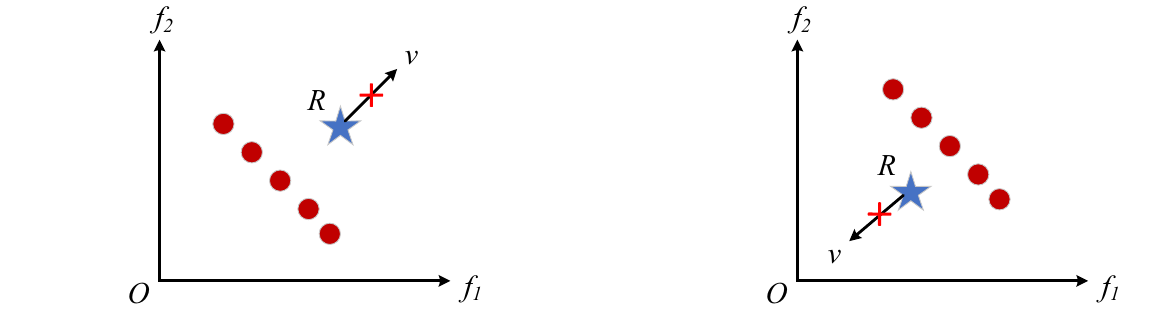
vector v , the following three cases are considered to set the